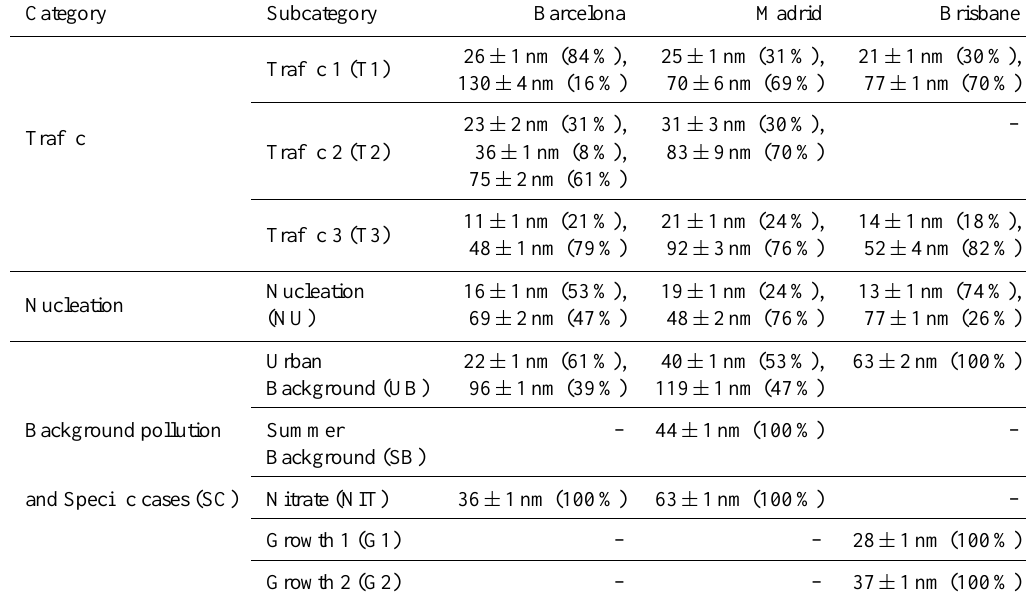
Table 2. Log-normal fitting peaks for each cluster category k -means size distribution at the main sites and the corresponding peak area